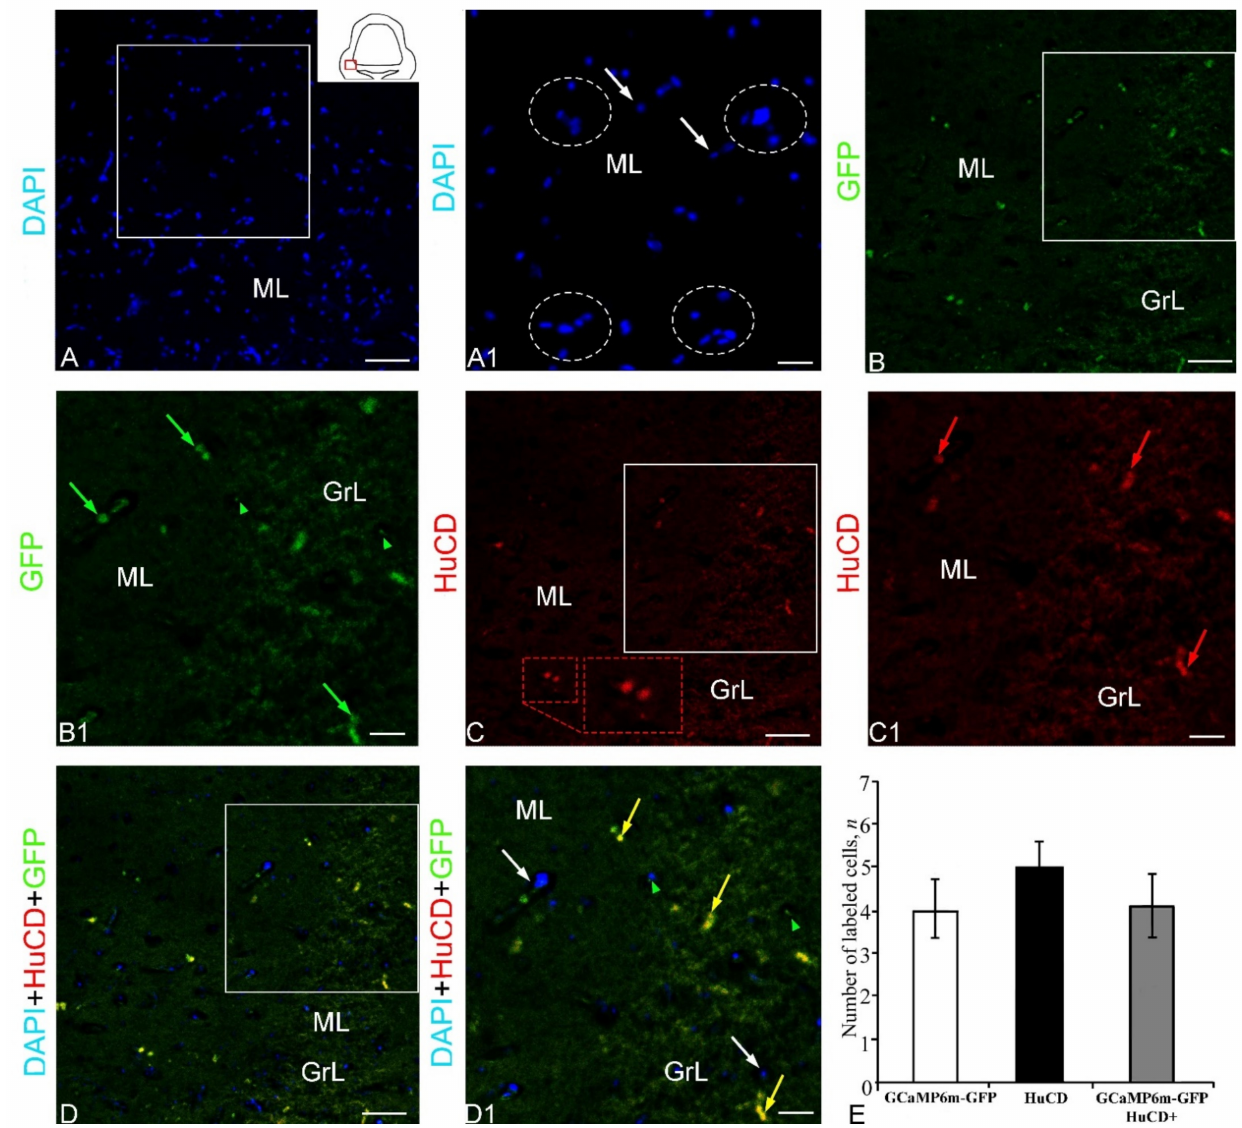
Figure 5. Z-stacks showing DAPI staining, localization of green fluorescent protein GFP and HuCD, and their co-localization in the basal region of the cerebellar body in juvenile chum salmon, O. keta